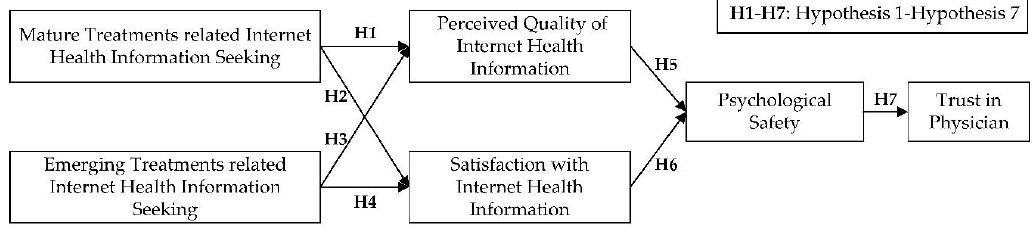
Figure 1. Research Model.